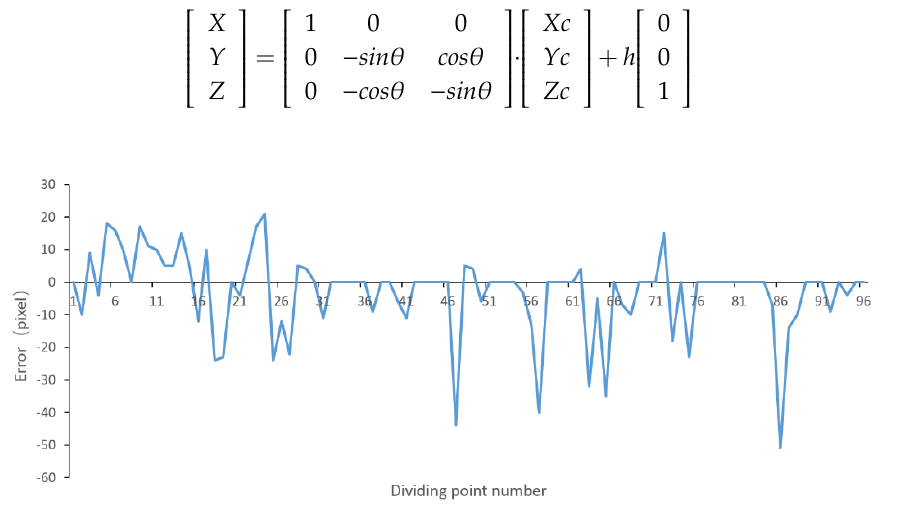
Figure 13. The error statistics of an image.